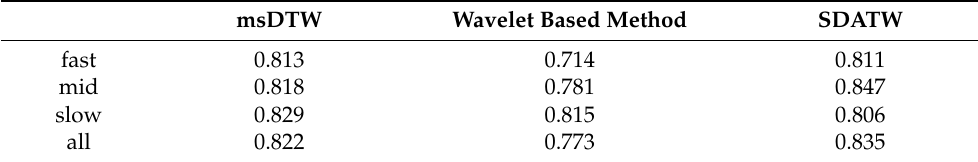
Table 7. Stride segmentation results of msDTW, wavelet-based method and SDATW in F-measure.